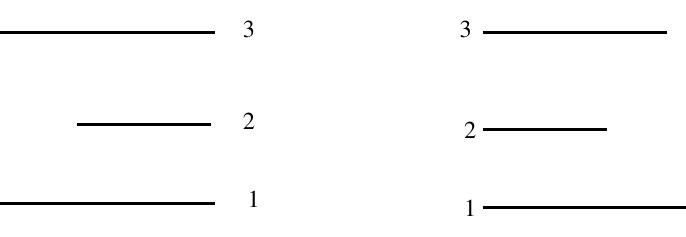
Figure 2 . Interaction